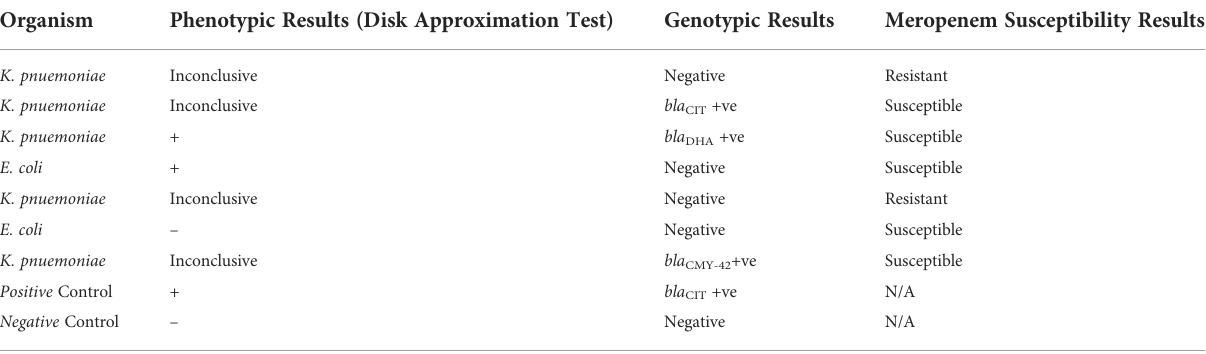
TABLE 2 Phenotypic and genotypic analysis of the seven cefoxitin resistant (CR) isolates for AmpC